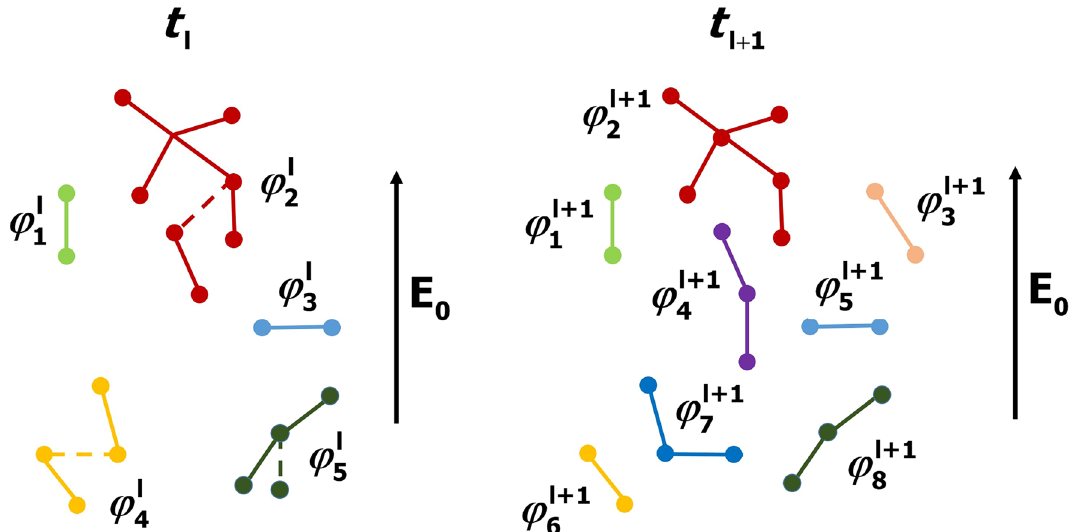
Figure 2. An example of alternating perfectly conducting clusters in an ambient electric field E 0 for the case 20 % (each time iteration 3 out of 15 links disappear and reappear in random sites). Line segments and of u = dots stand for links and spatial grid nodes, respectively. Individual equipotential clusters are shown in different colors. Model links which exist at the moment of time t l but disappear at the next time step t l dashed lines. The total number of links remains constant, while the number of clusters, as well as their electrical potentials and structures, can